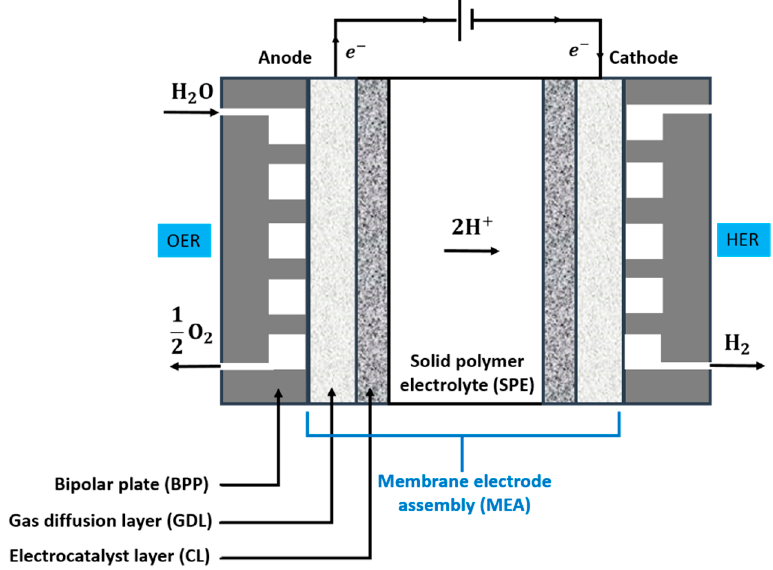
Figure 3. Basic, key components of a PEM WE.